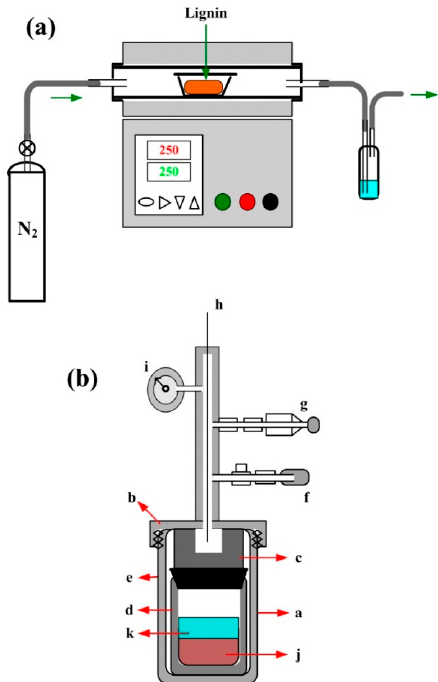
Figure 4. Two technical schemes used in the preparation of GMC samples. ( a ) The lignin pyrolysis